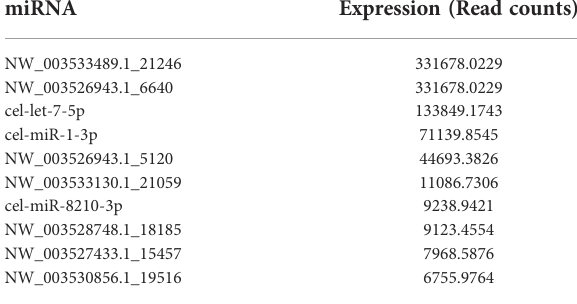
TABLE 1 Top 10 highly expressed miRNAs in T. spiralis extracellular vesicles. miRNA Expression (Read